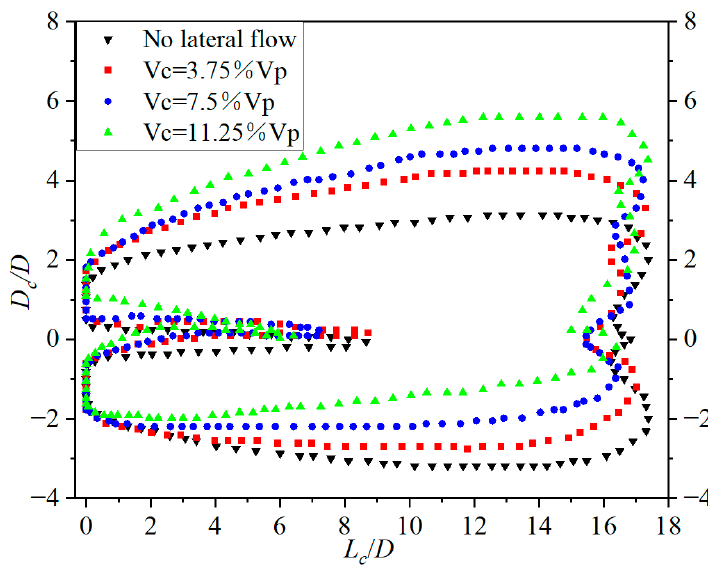
Figure 11. Comparison of the cavitation contours at t = 2 ms.